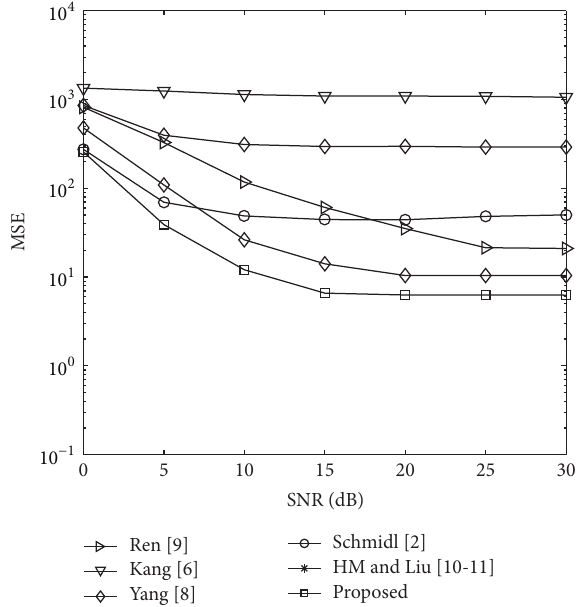
Figure 4: Timing MSE versus SNR for six methods in a 5-tap Rayleigh fading channel ( 𝑁 = 64 and 𝐺 = 12